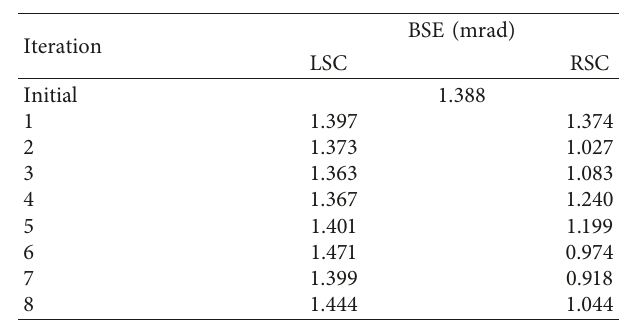
Table 3: The maximum BSE during IPD correction iteration for LSC/RSC.